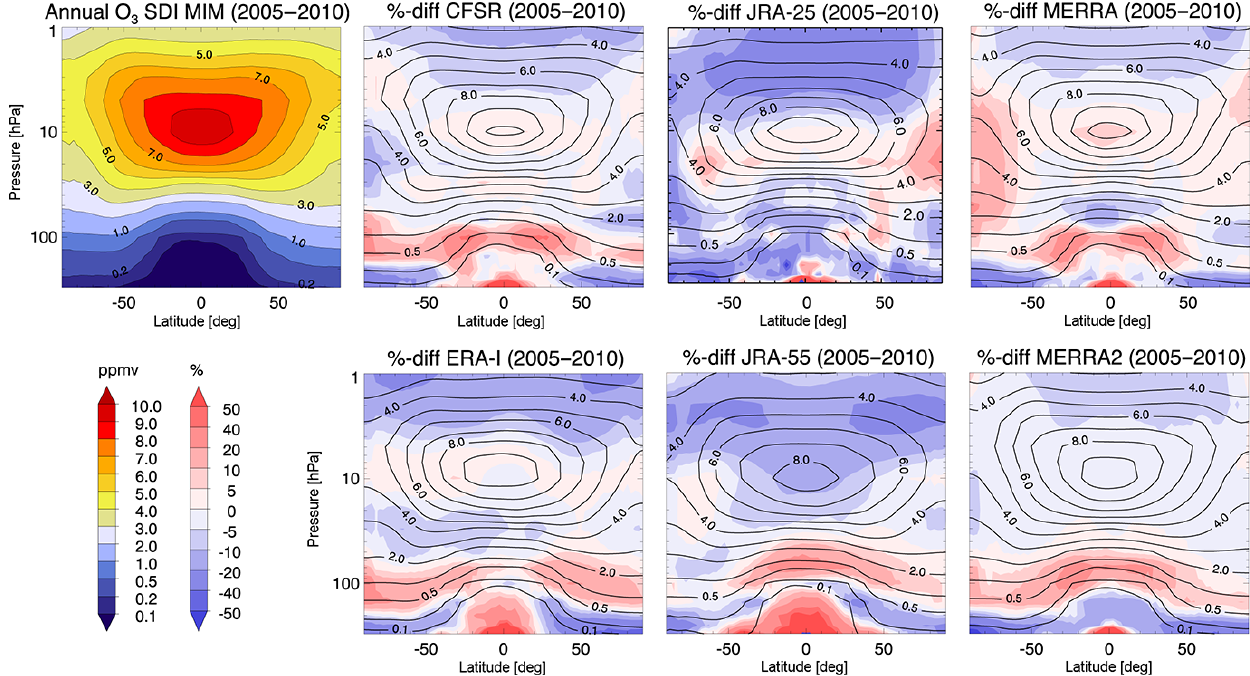
Figure 4. Multi-annual zonal mean ozone cross sections averaged over 2005–2010 for the SPARC Data Initiative multi-instrument mean (SDI MIM) (upper left), along with the relative differences between reanalyses and observations as (R i − MIM )/ MIM · 100, where R i is a reanalysis field (shading, other panels). Also shown in line contours are the respective zonal mean climatologies for the different